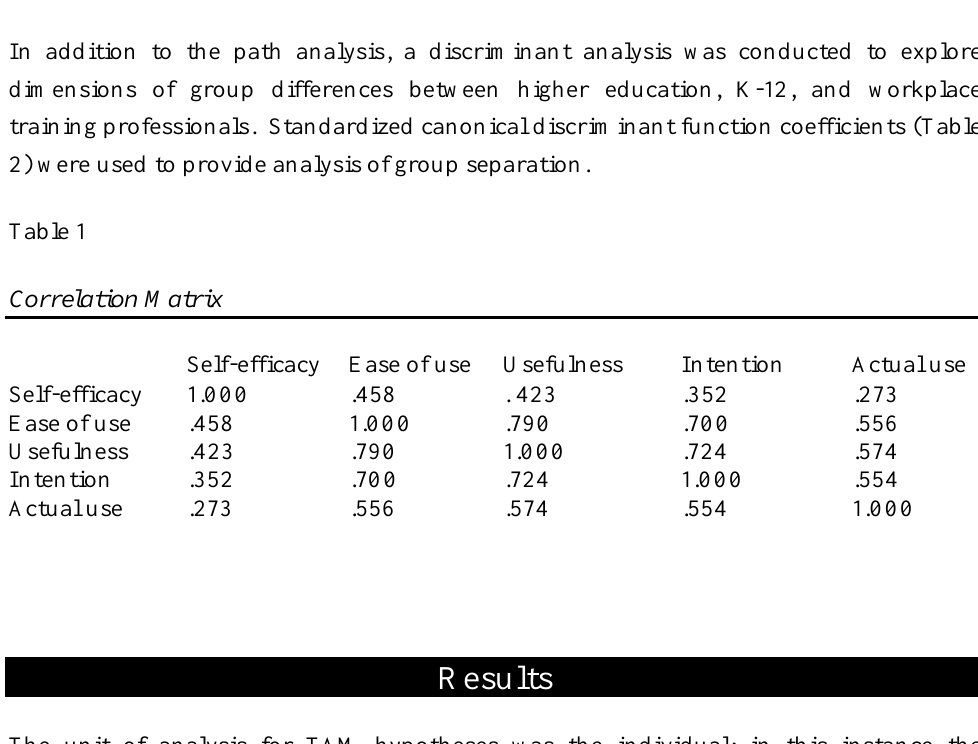
training professionals. Standardized canonical discriminant function coefficients (Table